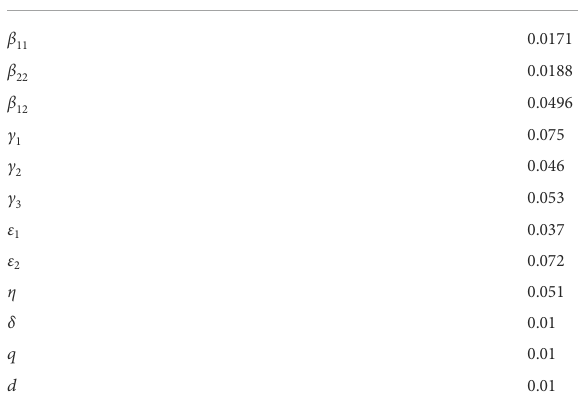
TABLE 2 Initial parameter